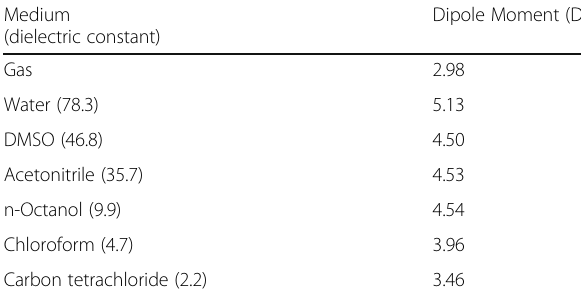
Table 3 Dipole moment (Debye, (D)) of betulinic acid in gas phase and in different solvents using